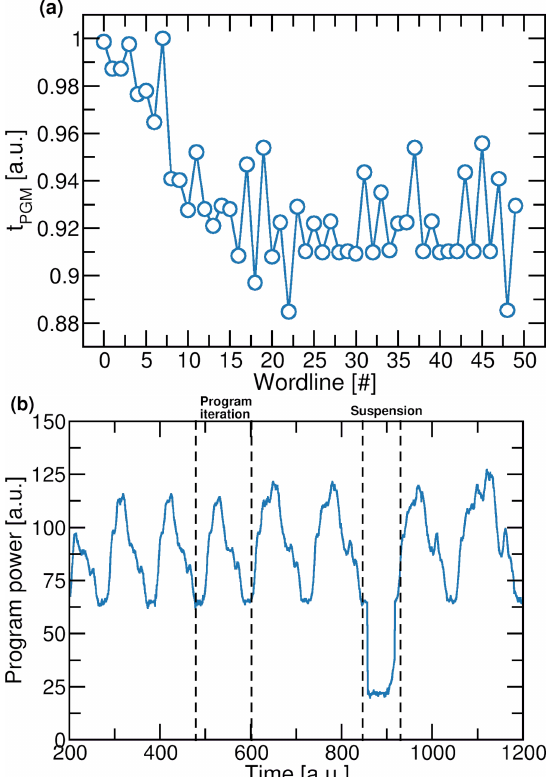
Figure 3. ( a ) t PGM measurements performed on 50 randomly sampled wordlines in a 3D NAND Flash block. ( b ) Power consumption measured during a program suspend